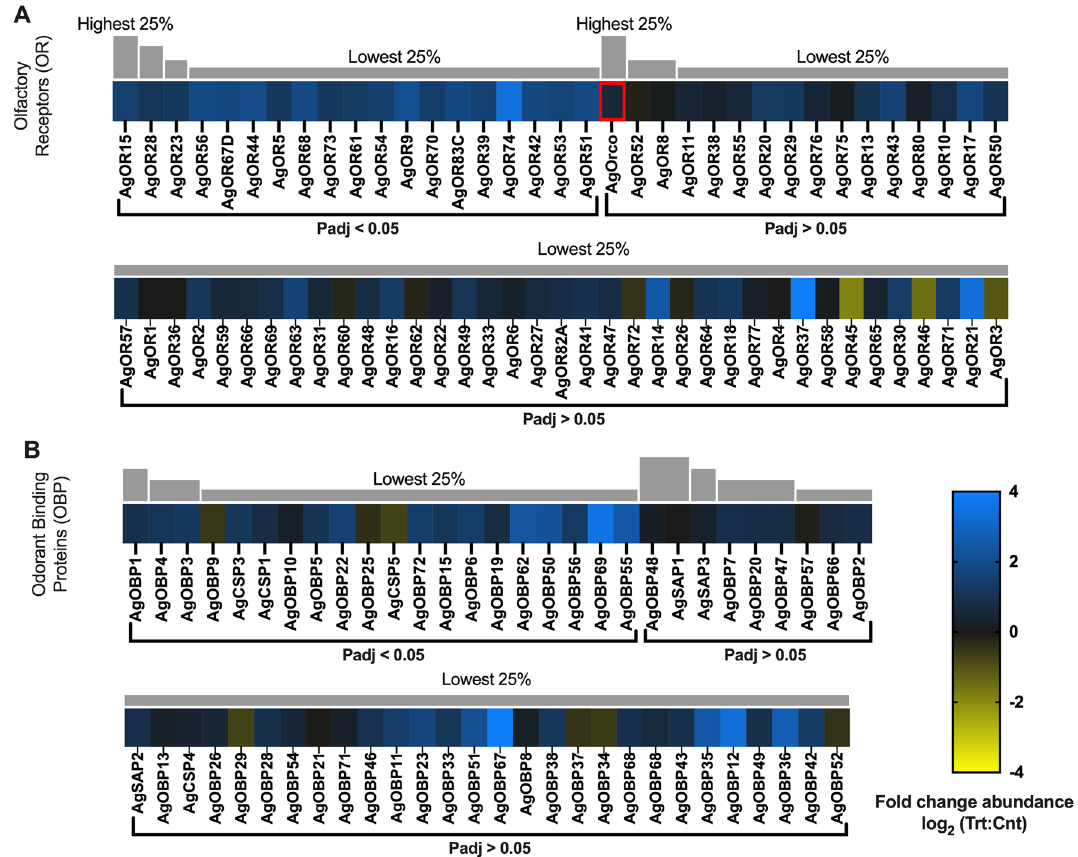
Figure 5. Chemosensory differential transcript abundances following relevant sporozoite infections. Chemosensory transcripts that were present at significantly higher (blue) or lower (yellow) levels in Plasmodium falciparum sporozoite infected treatments; non-differentially expressed chemosensory transcripts are denoted as zeros (black). Chemosensory genes within each family organized by adjusted p-value and subsequently arrayed left to right from most abundant to least abundant based on FPKM values (quartile bars above each image). ( A ) Odorant receptor family (OR). ( B ) Odorant binding protein family (OBP). Chemosensory co-receptors are identified by red boxes. Log 2 scale indicates transcript abundances that were significantly higher (blue) or lower (yellow) in sporozoite infected treatments (Trt) vs. naïve controls